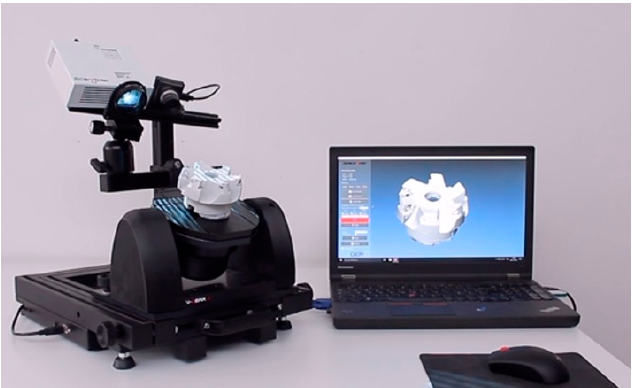
Figure 8. The prototype of the 3D scanning apparatus ScanRider while scanning a milling cutter.